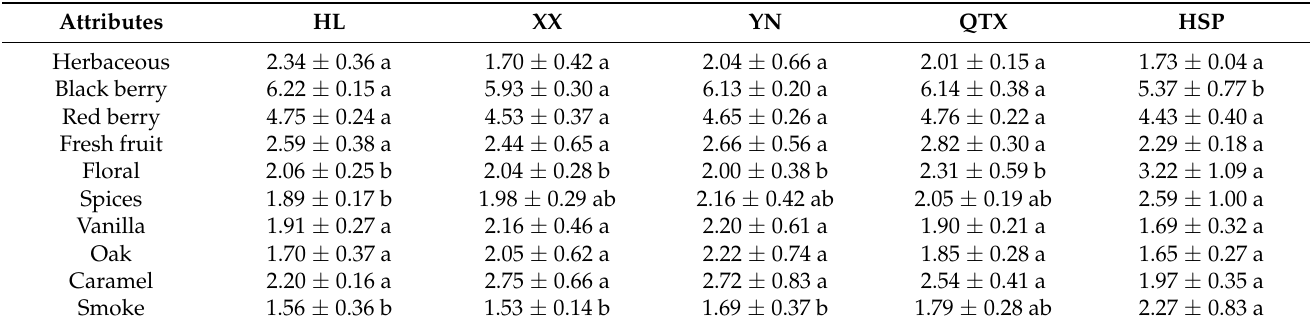
Table 3. One-way ANOVA of QDA sensory evaluation of Cabernet Sauvignon dry red wines in sub-regions of the Eastern Foothills of Helan Mountain in Ningxia